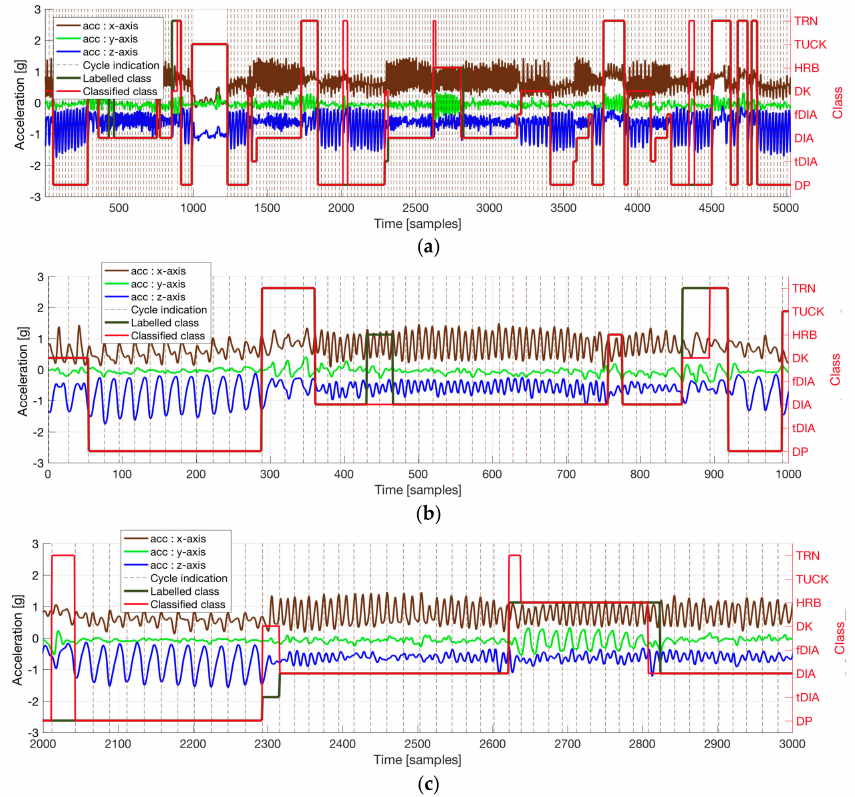
Figure A1. The entire test dataset from subject 1 at Natrudstilen is plotted in ( a ), while ( b , c ) shows an enlarged view of the parts of the dataset where the misclassifications